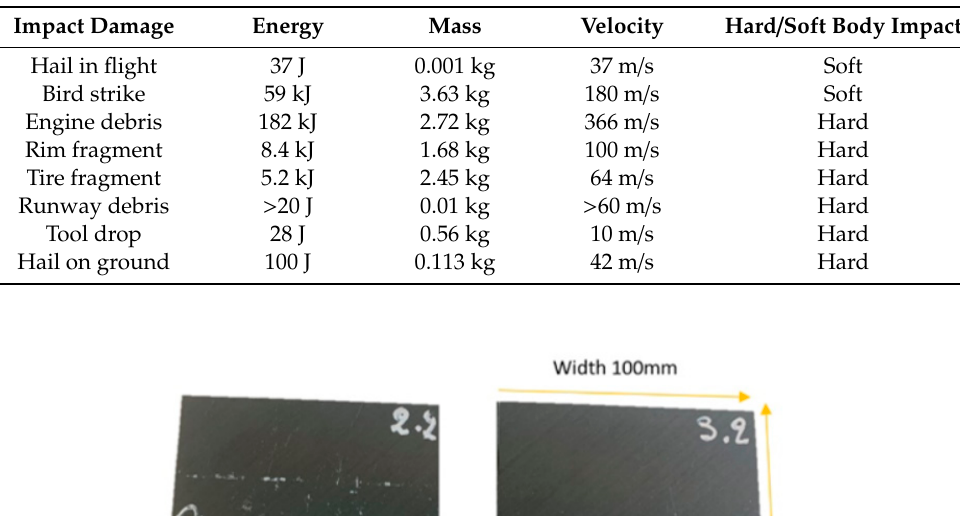
Table 2. Common examples of impact damage cases on a commercial aircraft [5].